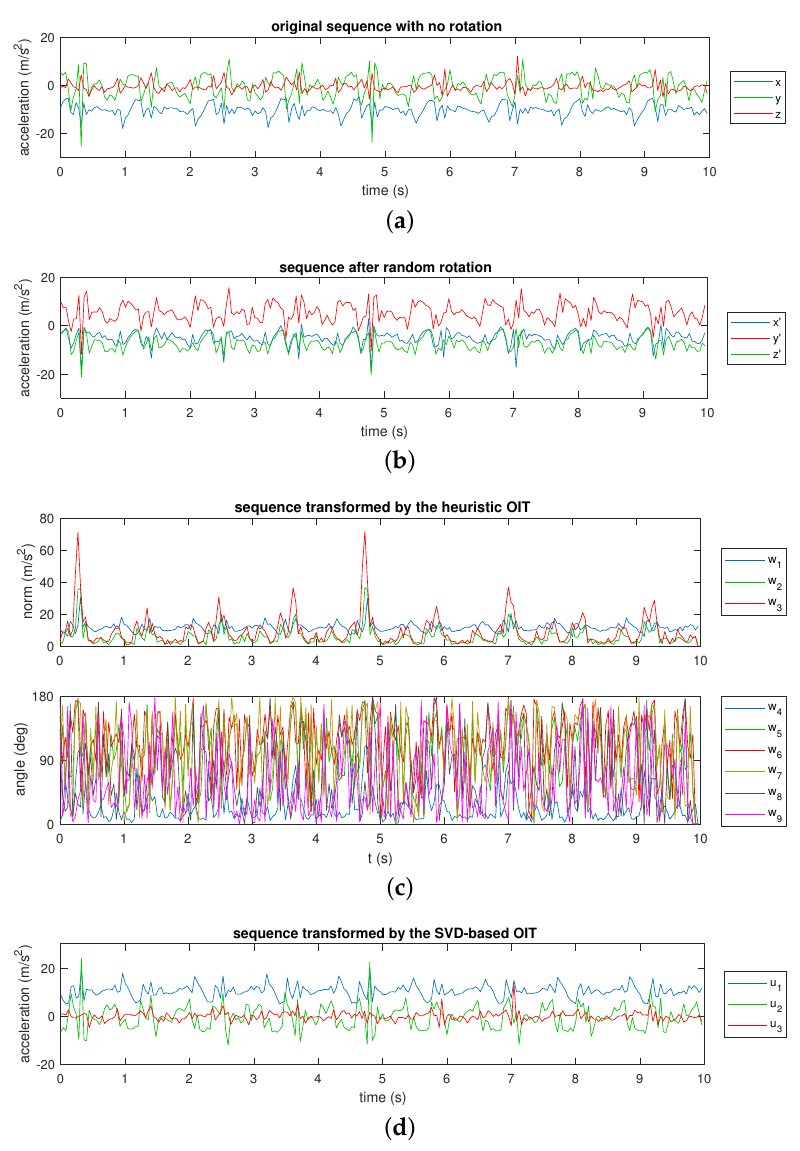
Figure 3. The original, randomly rotated and orientation-invariant sensor sequences. ( a ) Original and ( b ) randomly rotated accelerometer sequences while performing A 10 in dataset A. Orientation-invariant sequences transformed by the ( c ) heuristic and ( d ) SVD-based